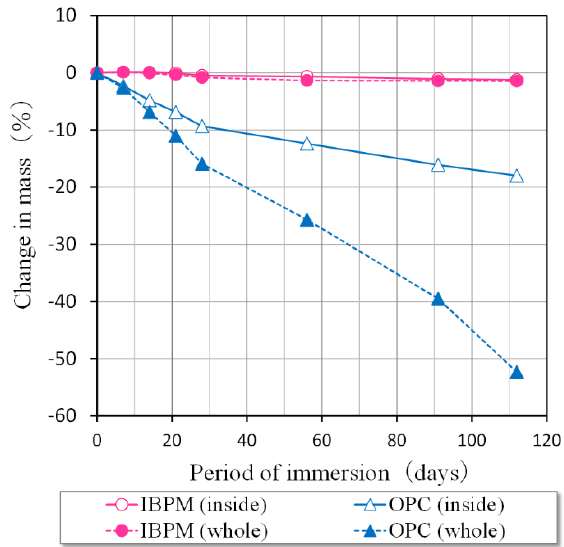
Figure 10. Change in mass of the centrifugally molded specimens by immersion in a sulfuric acid aqueous solution.